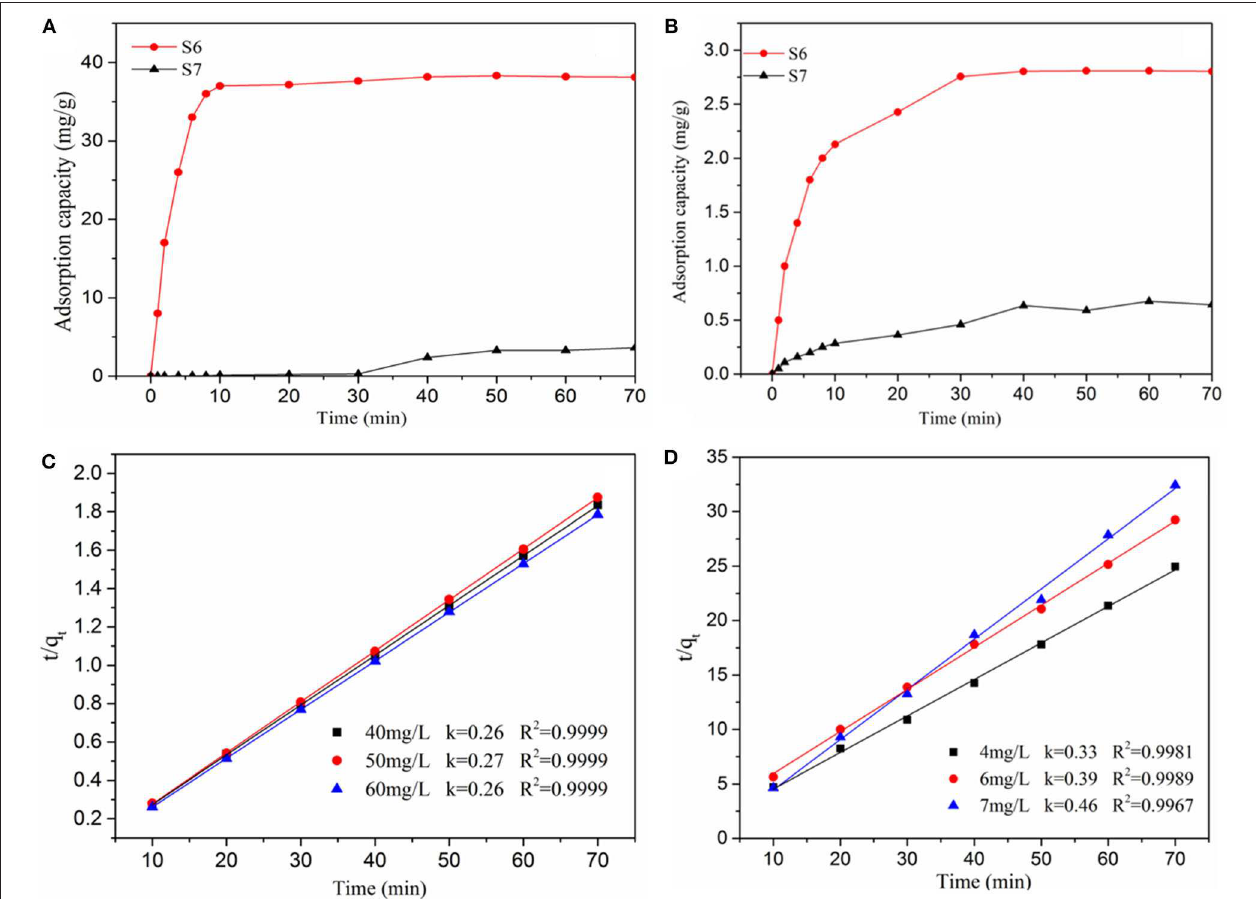
FIGURE 5 | The adsorption ability of samples S6 (Mg 2 + ) and S7 (TMCS) for different adsorbate (A) Methylene blue, (B) Rhodamine B; Pseudo-second-order for the adsorption of sample S6 (Mg 2 + ) with different adsorbate (C) MB, (D) RhB.